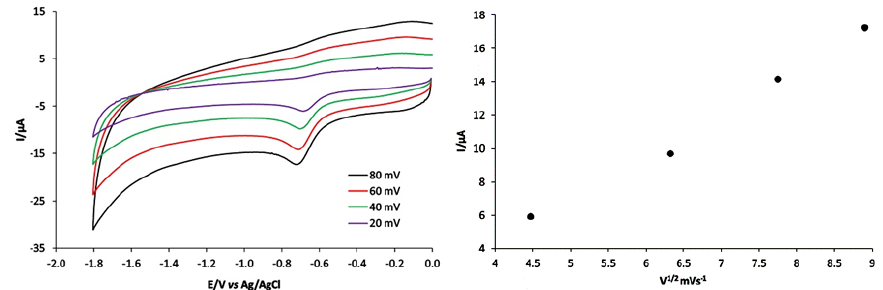
Figure 7. Cyclic voltammograms of 0.45 mM [Co(PLITSC-H) 2 ]BrNO 3 CH 3 OH at carbon electrode, at different scan rates in DMF containing 0.2M [NBu 4 ][BF 4 ] and ips versus the quare-root of the scan